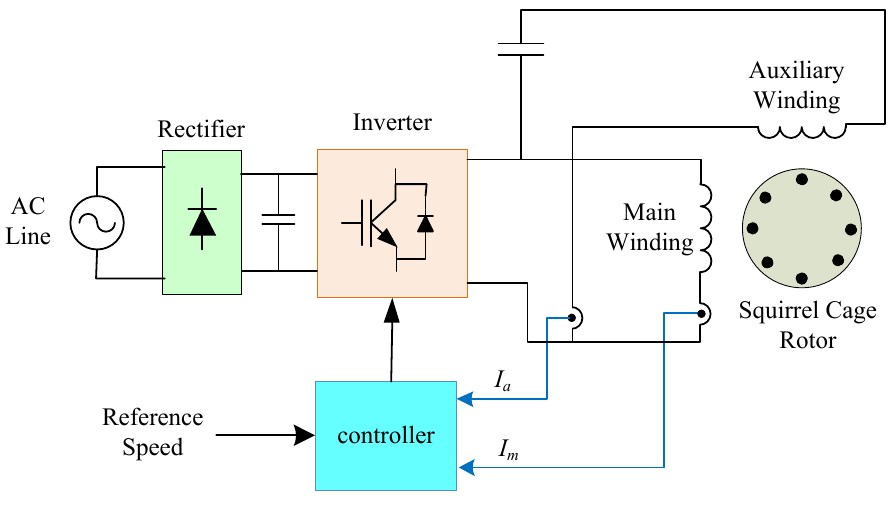
Figure 1. Schematic of SPIM drive.